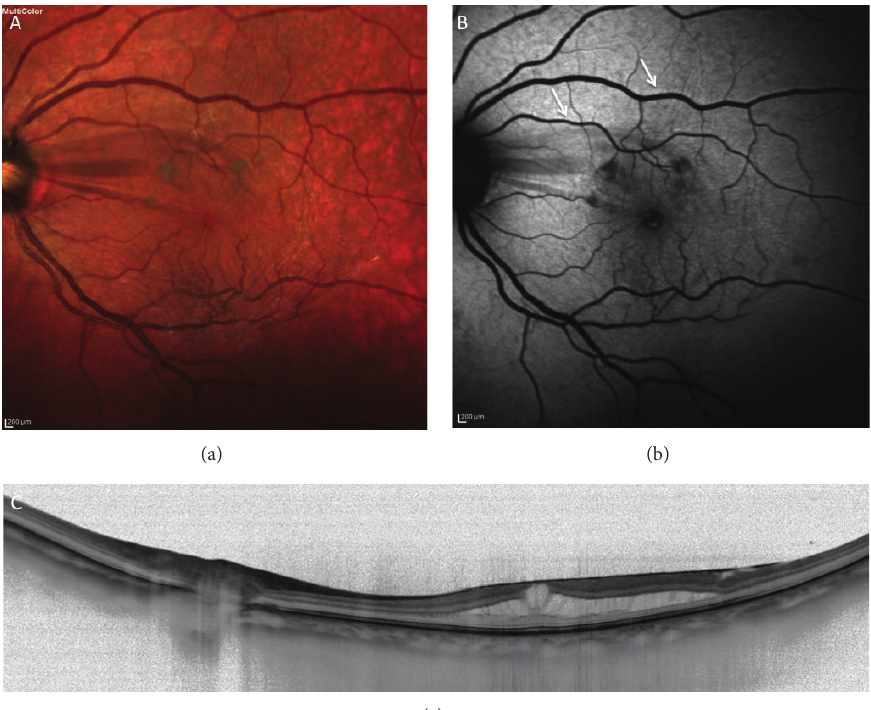
Figure 6: (a) The multicolor fundus photograph shows an iERM (a) with presence of “retinal vessel printings” (b) at fundus autofluorescence induced by tractional forces. The hyperautofluorescent lines (arrows) indicate the original location of the retinal vessels. (c) OCT scan of the same patient shows the cystoid macular edema induced by tractional